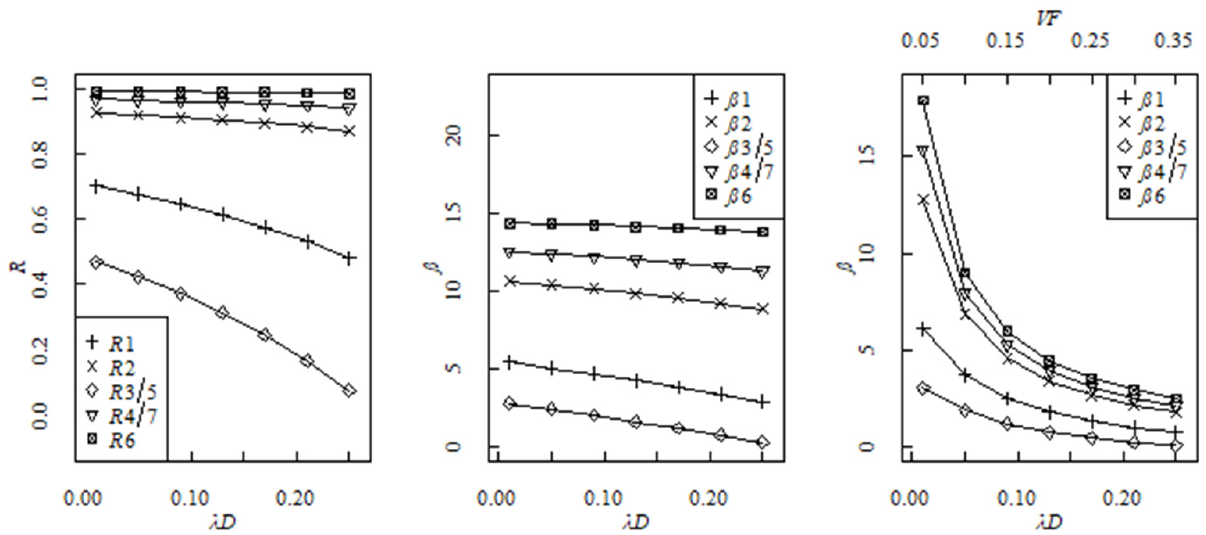
Figure 7. Structural robustness evaluation index ( R ) and structural reliability index ( β ) of the truss beam subjected to damage effect ( λ D ) and variation factor ( VF ) (Left : R vs. λ D , middle : β vs. λ D , and right : β vs. λ D